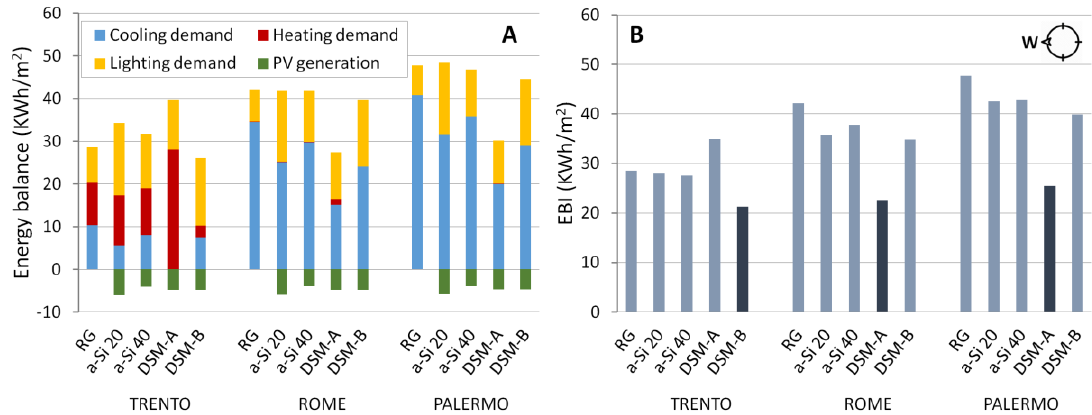
Figure 10. ( A ) Energy balance for the various STPV tested, compared to the reference glass (RG) of the STD building facing west at the three locations; ( B ) EBI index evaluated for the same orientation and glazing elements.